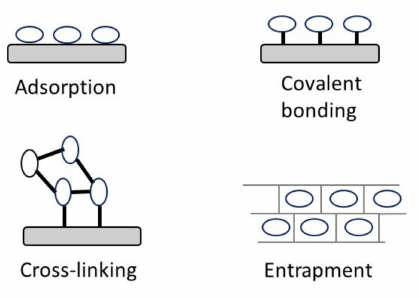
Figure 1. Immobilization